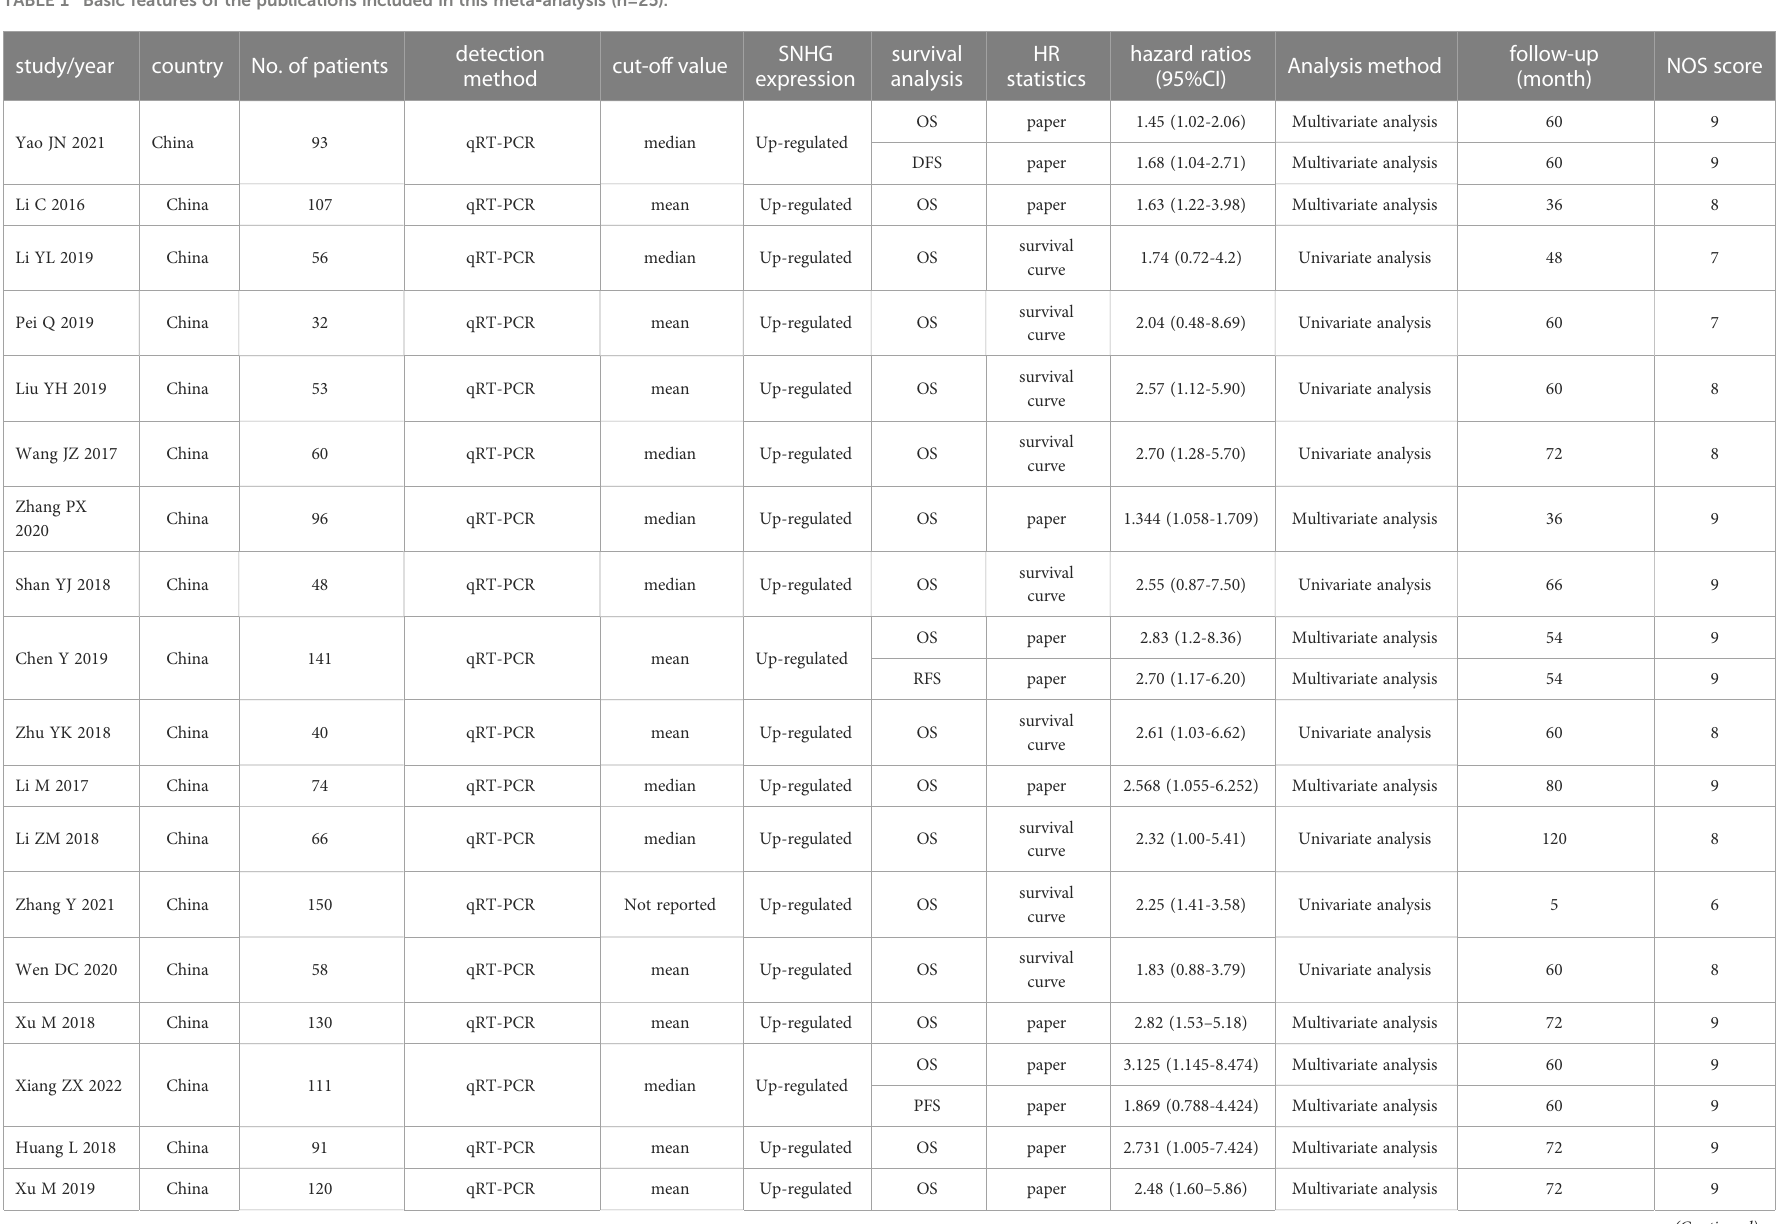
TABLE 1 Basic features of the publications included in this meta-analysis